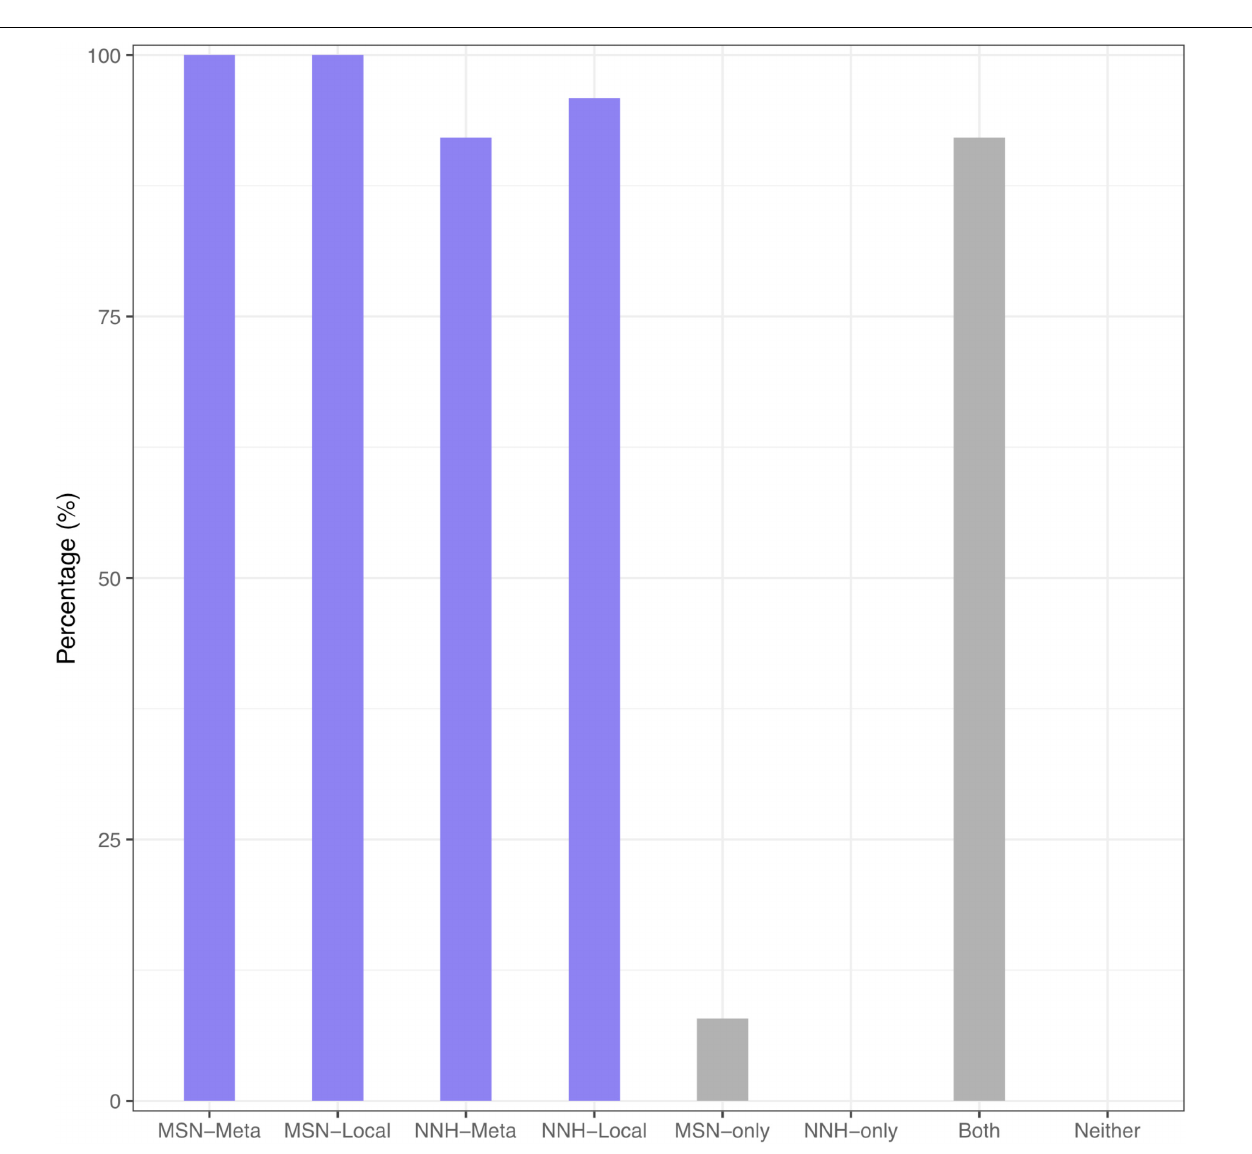
FIGURE 2 | The passing percentage from testing the MSN/NNH models: ( i ) The left block (purple) shows the percentage for passing MSN at metacommunity, MSN at local community, NNH at metacommunity, and NNH at local community level, respectively; ( ii ) The right block (gray) shows the percentage for passing MSN-only, NNH-only, both MSN and NNH, and neither MSN nor NNH, all fitted at the metacommunity level. The two blocks were displayed with different objectives: the left was from the perspective of comparing the performance of MSN vs. NNH, and the right was from evaluating the overlap or specificity of the MSN vs. NNH